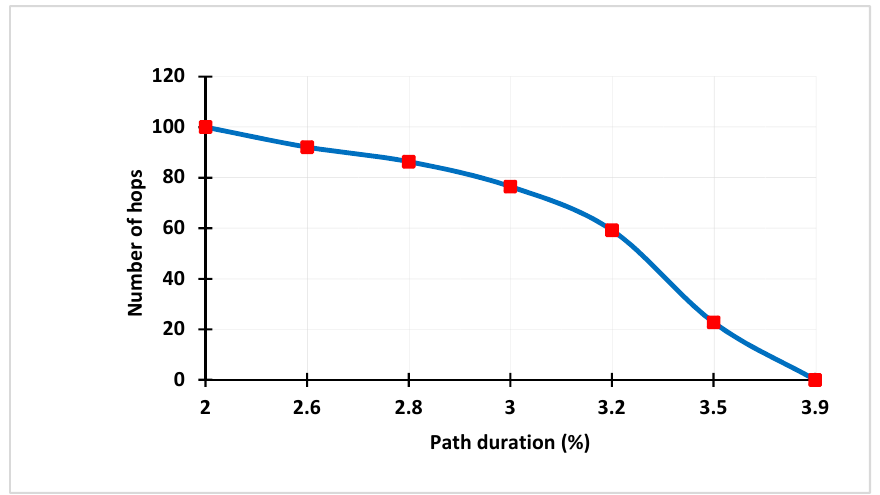
Figure 11. DSDV path duration vs. number of hops.